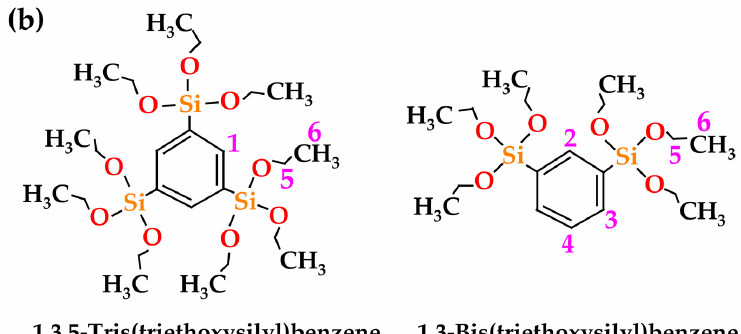
Figure 1. ( a ) 1 H-NMR spectrum of two 135TTEB precursor solutions, one extracted at 100 – 110 °C and another one at ≥ 130 °C, where the signals are assigned as follows: 1 = δ 8.06 (s, 3H, ArH),